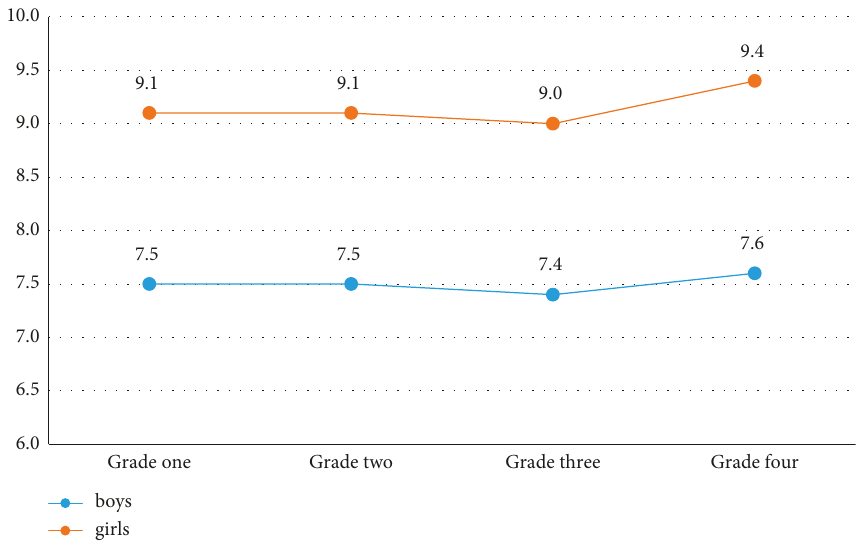
Figure 1: The change curve of the 50m race result between boys and girls. Table 4: Girls’ standing long jump scores and grade ratio.